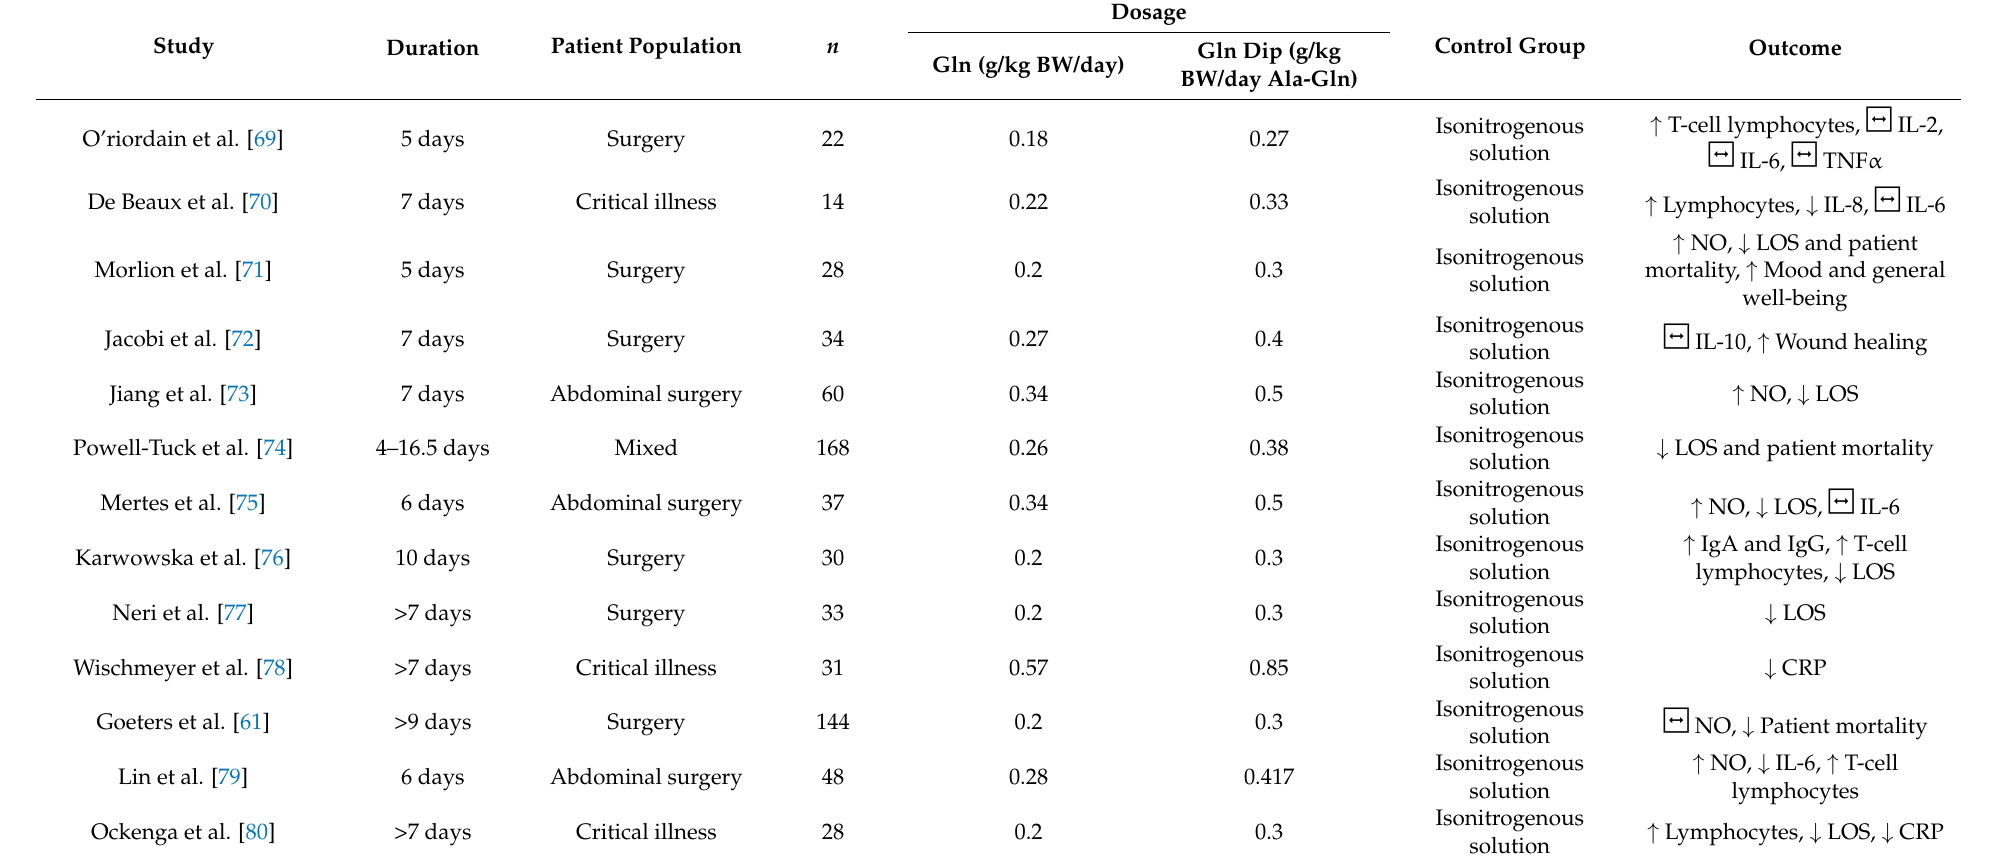
Table 3. Studies evaluating the effect of glutamine supplementation on wound healing and reported outcomes.